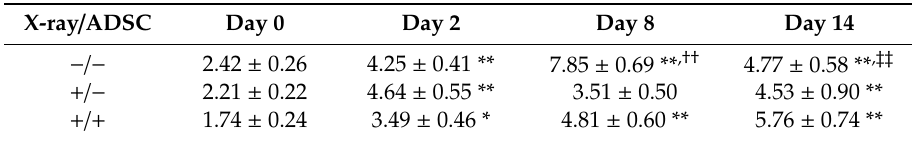
Figure 2. Number and exclusive area of lymphatic vessels with lymphatic vessel endothelial hyaluronan receptor 1 (LYVE-1) immunoreactivity. ( A ) Representative images of immunohistochemistry using anti-LYVE-1 antibody. Scale bars (magnification): 50 µ m (200 × ). ( B ) Number of lymphatic vessels in high power field (HPF) (mean ± SE). (C) Exclusive area of lymphatic vessels in HPF (mean% ± SE). In (B) and ( C ), results of multiple comparisons within the same day groups are indicated. ** p < 0.01: significantly di ff erent between X-ray / ADSC ( − / − ) and X-ray / ADSC ( +/ − ). †† p < 0.01: significantly di ff erent between X-ray / ADSC ( − / − ) and X-ray / ADSC ( +/+ ). ‡ p < 0.05, ‡‡ p < 0.01: significantly di ff erent between X-ray / ADSC ( +/ − ) and X-ray / ADSC ( +/+ ). Symbols represent each study group ( n = 6 mice / group): X-ray / ADSC ( − / − ) ( • ), X-ray / ADSC ( +/ − ) ( (cid:52) ), X-ray / ADSC ( +/+ ) ( (cid:78) ). Table 1. Mean lymphatic vessel areas with lymphatic vessel endothelial hyaluronan receptor 1 (LYVE-1) immunoreactivity (mean × 10 3 pixel ± SE).